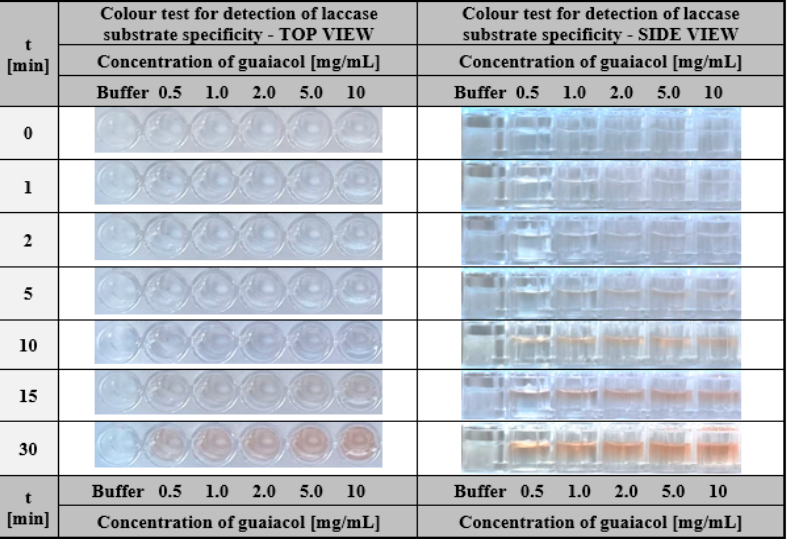
Figure 11. The visual response obtained after a different time of hydrogel-based test with immobilised laccase from Trametes versicolor (final concentration 200 µg/mL) performed for guaiacol solutions with a concentration in the range of 0.5–10 mg/mL.